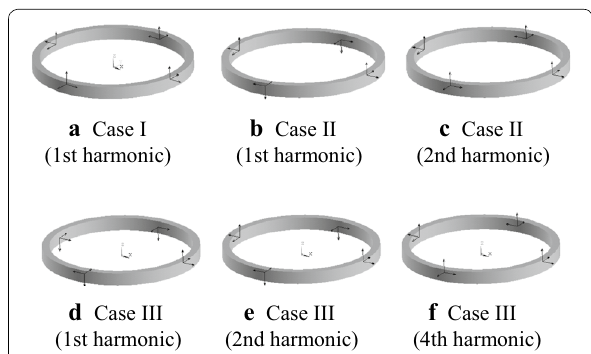
Figure 4 Mesh excitations on the helical ring gears